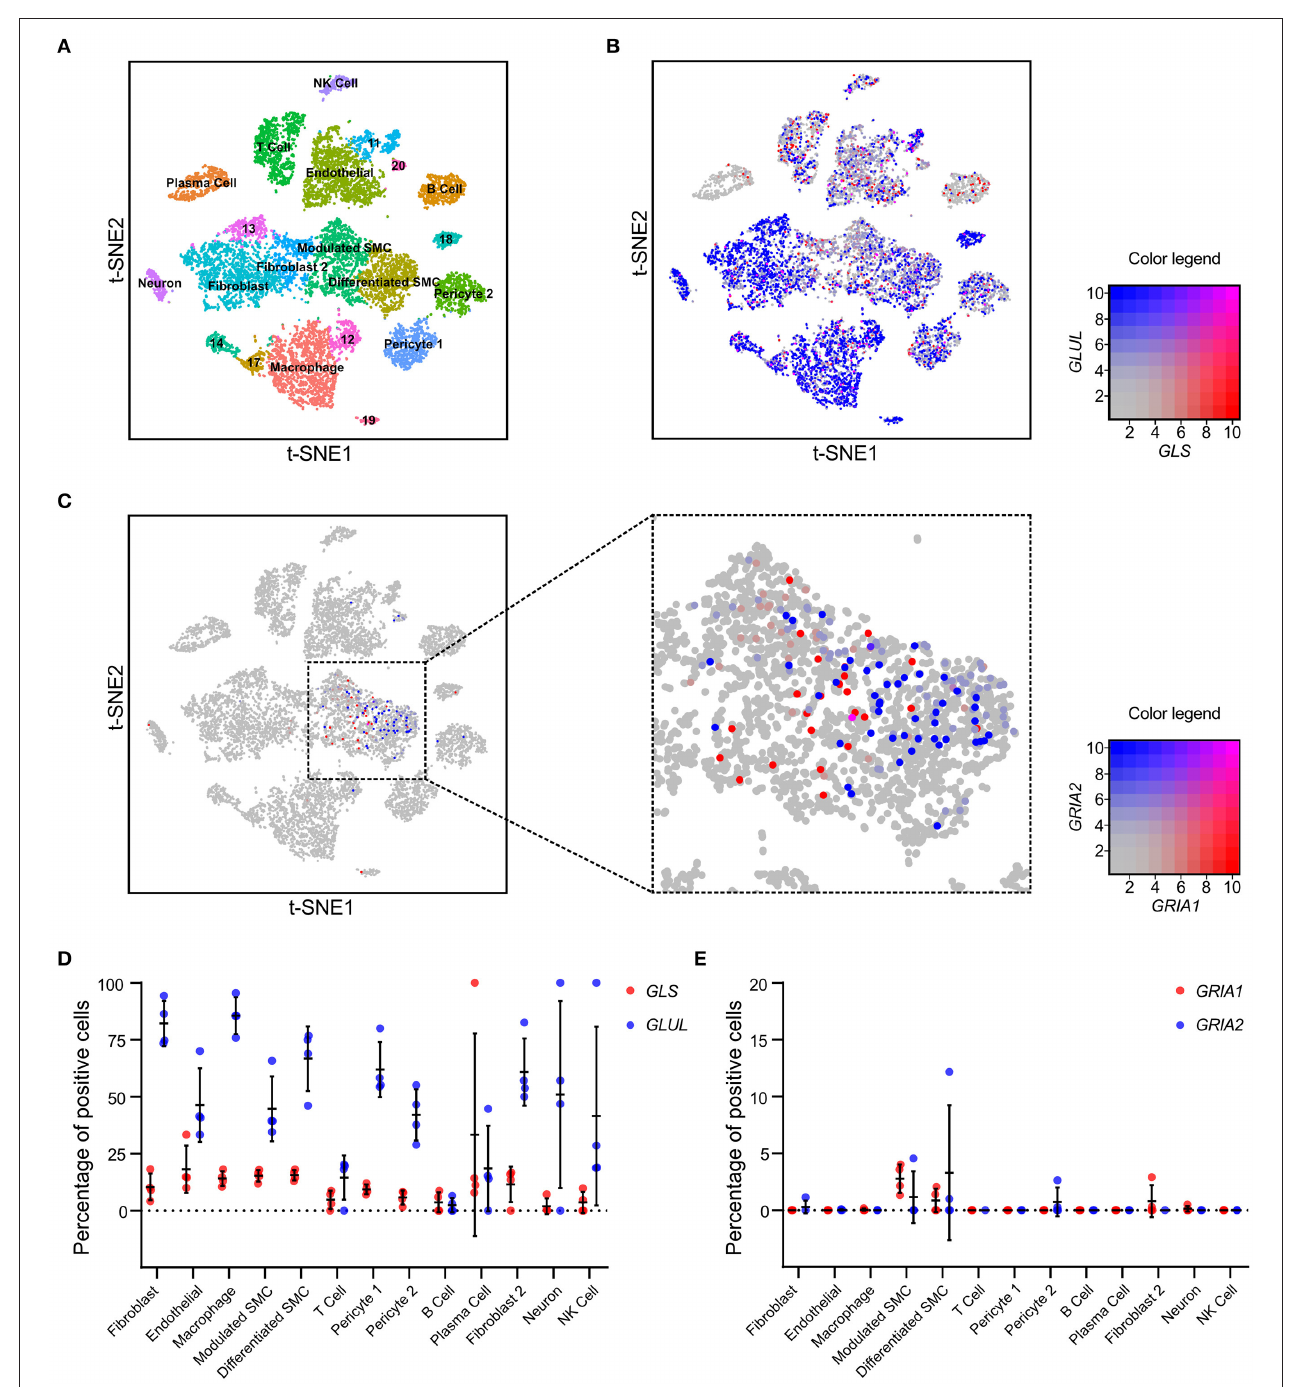
FIGURE 2 | VSMCs express AMPA-type glutamate receptors in atherosclerotic plaques. (A) tSNE visualization of single cell transcriptomic analysis of plaques ( n = 5) derived from the right coronary artery of human patients ( n = 4), colored according to broad cell clustering as indicated in the figure. Numbers denote unidentified clusters. NK, natural killer; SMC, smooth muscle cell. (B) tSNE visualization of single cell transcriptomic analysis of GLS (red) and GLUL (blue) expression overlaid on the cell clusters from (A) . Color legend (right) indicating relative expression levels for GLS1 on x-axis and GLUL on y-axis. (C) tSNE visualization of single cell transcriptomic analysis of GRIA1 (red) and GRIA2 (blue) expression overlaid on the cell clusters from (A) . Color legend (right) indicating relative expression levels for GRIA1 on x-axis and GRIA2 on y-axis. (D) Dot plot visualization of the percentage of cells positive for GLS (red) and GLUL (blue) expression within the identified cell clusters. Error bars indicate SD, n = 4 patients. (E) Dot plot visualization of the percentage of cells positive for GRIA1 (red) and GRIA2 (blue) expression within the identified cell clusters. Error bars indicate SD, n = 4 patients.